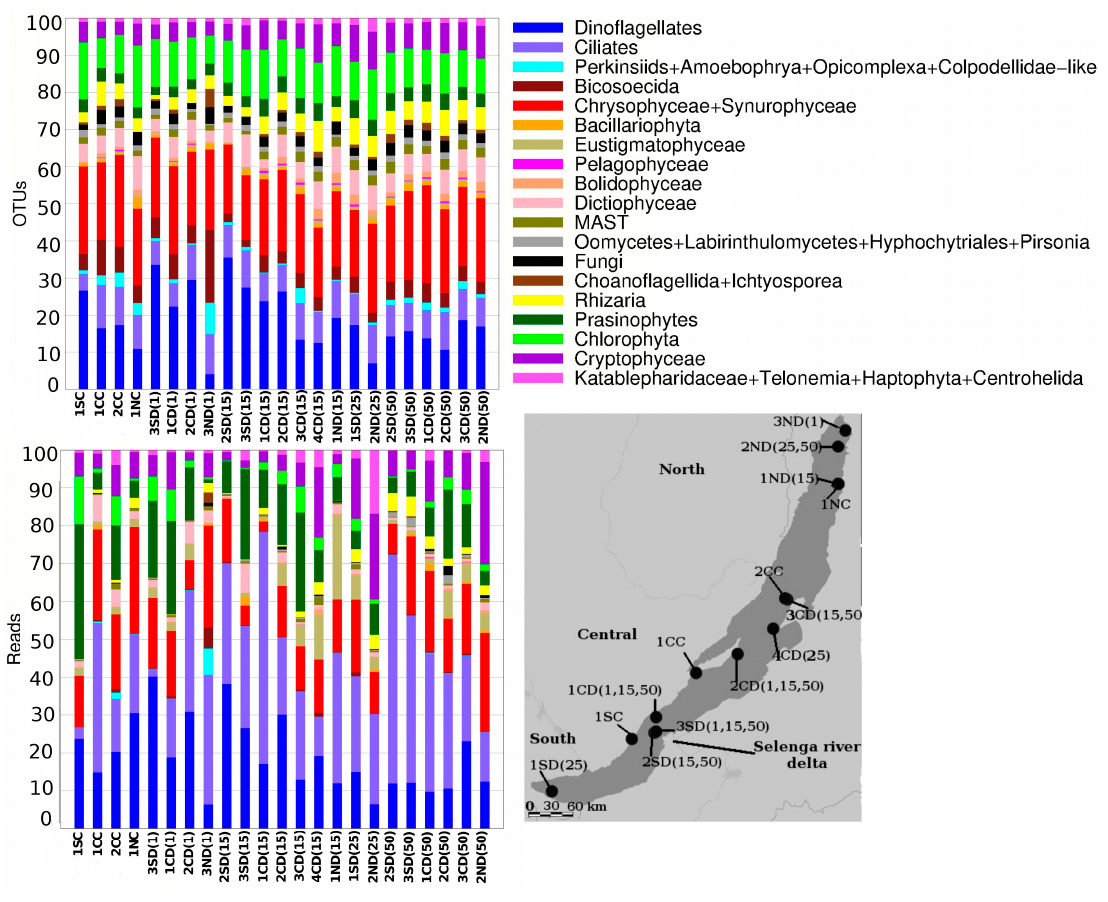
Figure 3. Histograms showing the relative proportion of different OTUs ( a ) and 18S rDNA amplicon reads ( b ), assigned to high-rank taxa across different sample sites.